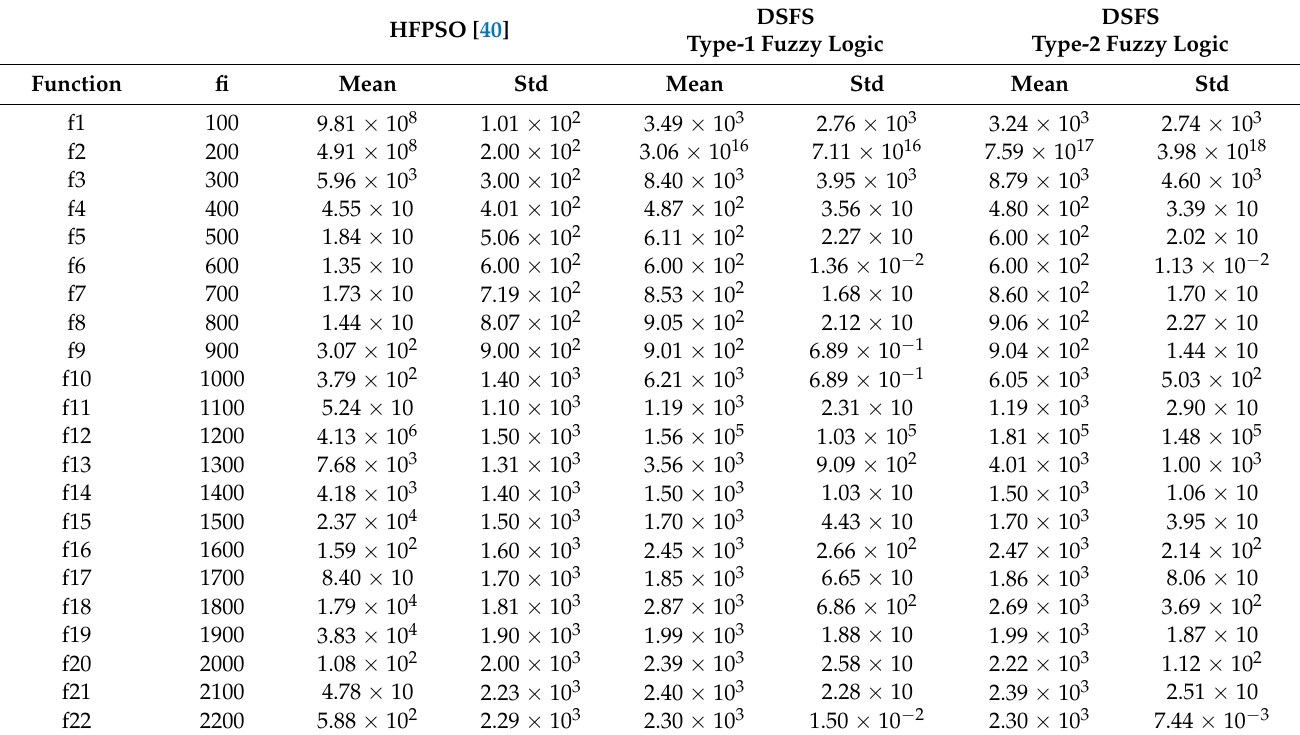
Table 7. HFPSO vs. DSFS results with 30